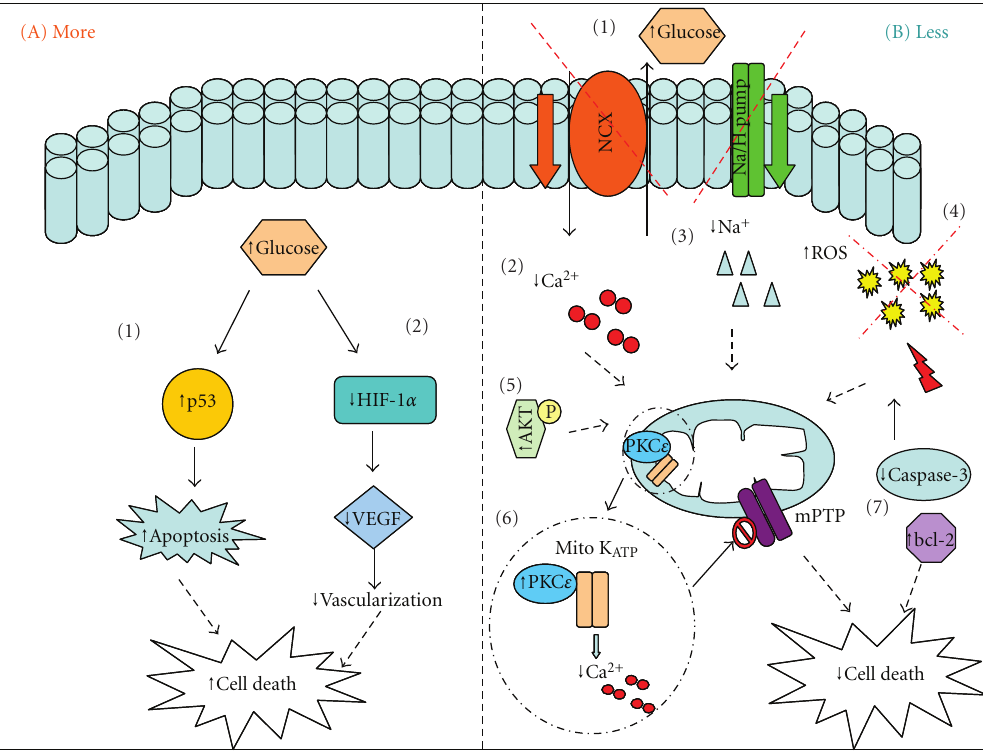
Figure 2: Possible mechanisms that make the diabetic heart more or less susceptible to infarction following ischemia reperfusion. (A) Diabetes can render the heart more susceptible to infarction. (A1) A diabetes-associated increase in the activity of p53, leading to the initiation of cell death pathway [29]. (A2) High-glucose causes a decrease in the activity of transcription factor HIF-1 α , a subsequent downregulation of VEGF and less revascularization following ischemia [66]. This results in cell death and larger infarct volume. (B) Diabetes can protect the heart against infarction. (B1) Hyperglycaemia is cardioprotective due to the increased availability of glucose which is the hearts preferred substrate in times of stress. (B2/3) The Na + /Ca 2+ and Na + /H + exchangers in the diabetic heart reportedly have decreased activity; therefore the diabetic heart accumulates less of these ions preventing overload and the associated detrimental e ff ects [20]. (B4) Diabetes is associated with an increased release of reactive oxygen species (ROS); a possible subsequent release of free radical scavenging enzymes increase the level of antioxidants within the myocardium protecting the heart from the consequence of IRI [20]. (B5) An increased basal level of prosurvival kinases in diabetes [57]. (B6) PKC- ε increases in diabetes, activating the mitochondrial K ATP channel causing subsequent reduction in calcium accumulation and increasing ATP synthesis. PKC- ε also persistently translocate during ischemia but only in diabetic hearts [52]. (B7) High glucose caused reduction in cell death proteins and increased anti apoptotic bcl-2